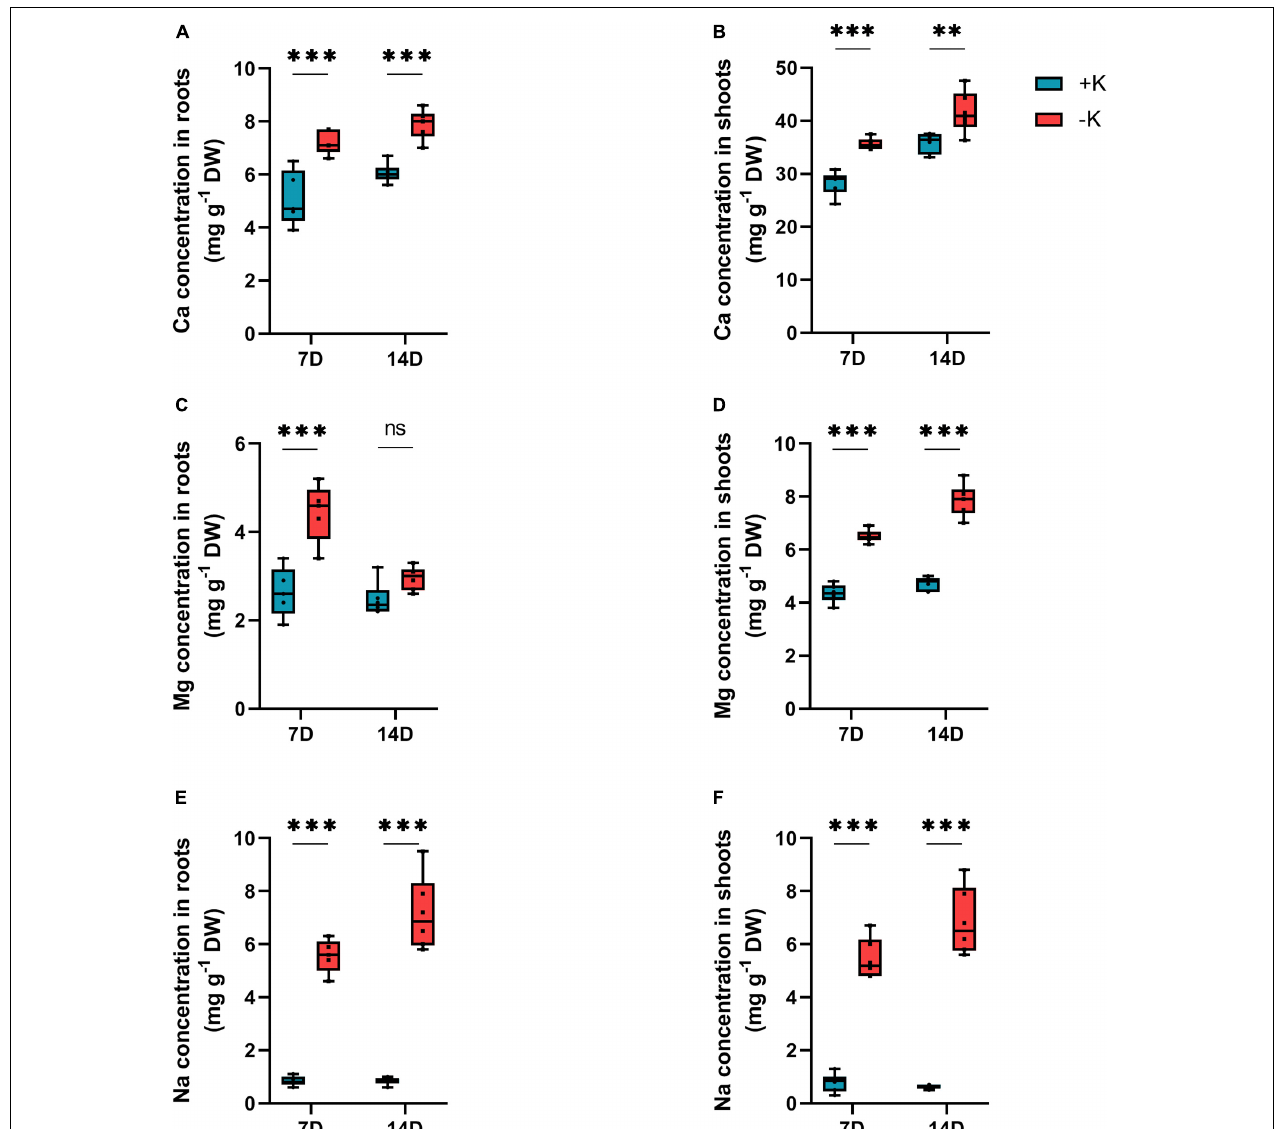
FIGURE 3 | Influence of K deficiency on mineral nutrition status in rapeseed plants. (A) Ca concentration in roots; (B) Ca concentration in shoots; (C) Mg concentration in roots; (D) Mg concentration in shoots; (E) Na concentration in roots, and (F) Na concentration in shoots. Plants were grown in a hydroponic culture under either –K (0 mM) or + K (2 mM). The roots and shoots were harvested after 7 or 14 days of K deprivation. Asterisks denote the significant level of the difference according to t -test ( ∗ p < 0.05; ∗∗ p < 0.01, and ∗∗∗ p < 0.001, n = 6).